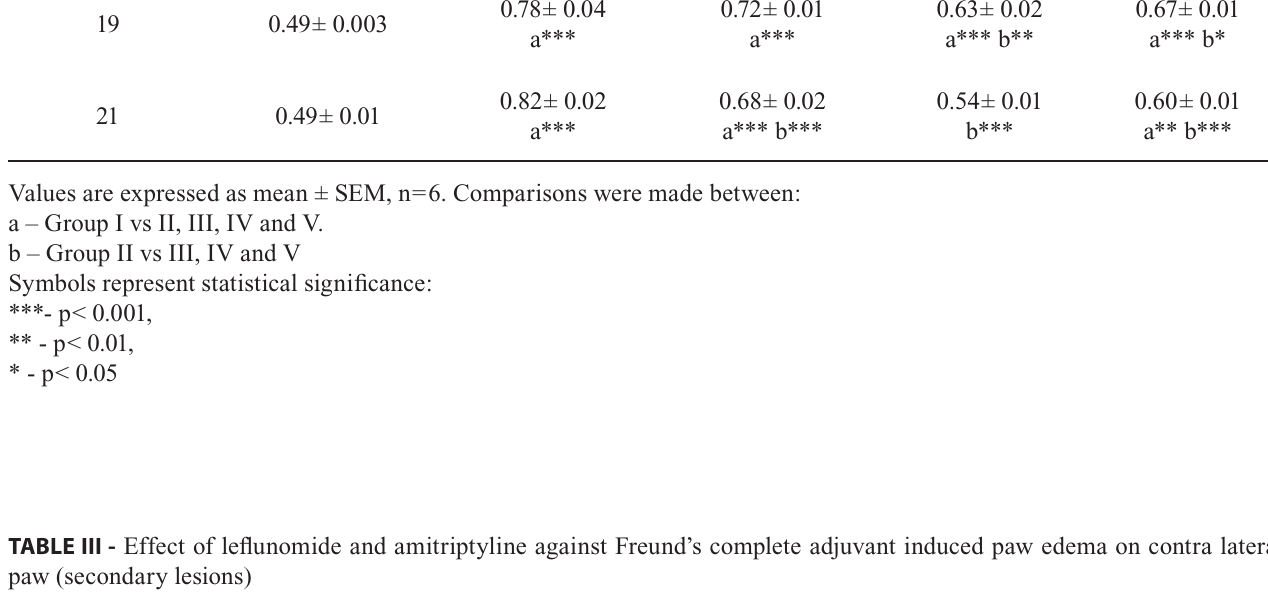
TABLE III - Effect of leflunomide and amitriptyline against Freund’s complete adjuvant induced paw edema on contra lateral paw (secondary lesions)